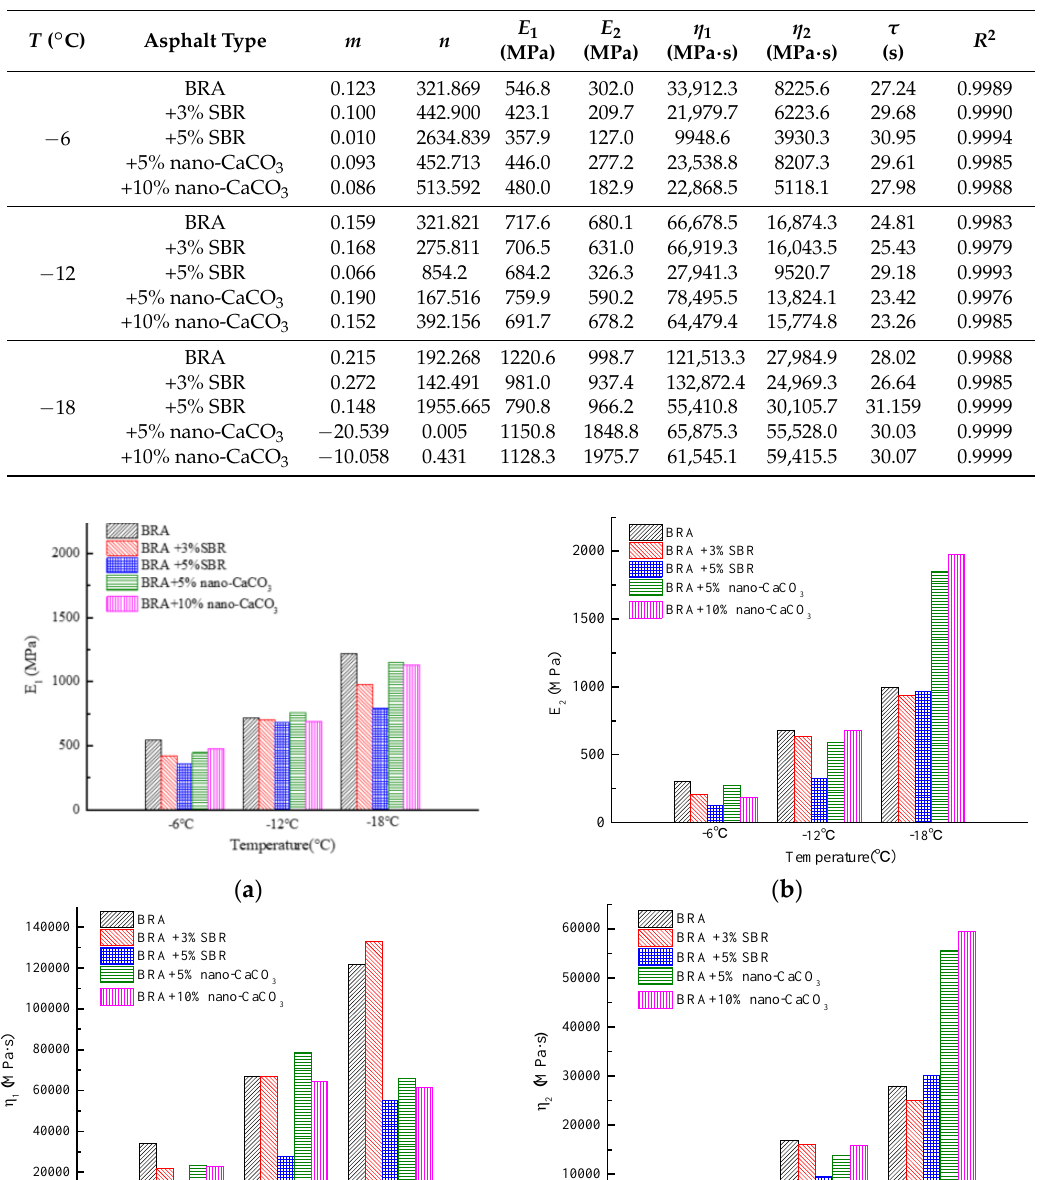
Table 7. Fitting results of viscoelastic damage model and Burgers’ model for different asphalts.